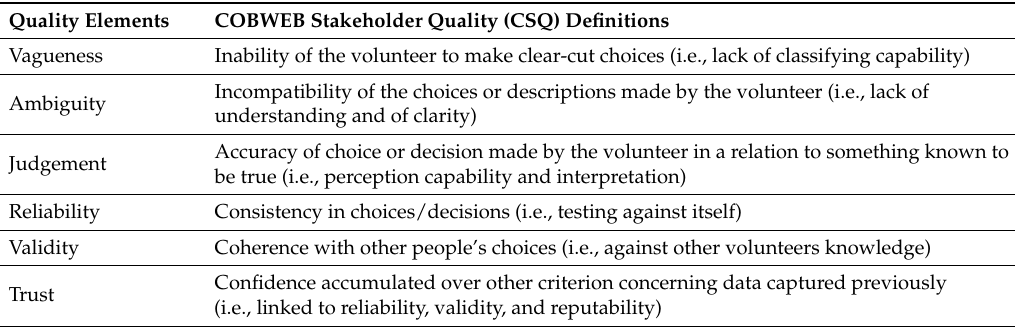
Table 1. Quality elements for the COBWEB (Citizens Observatory WEB) stakeholder quality (CSQ) model